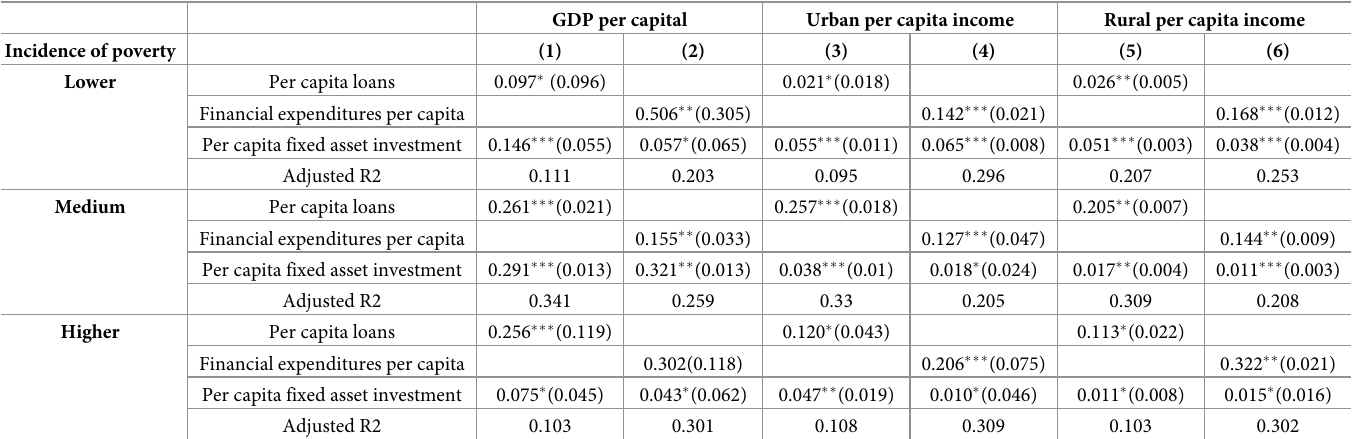
Table 8. Piecewise linear regression